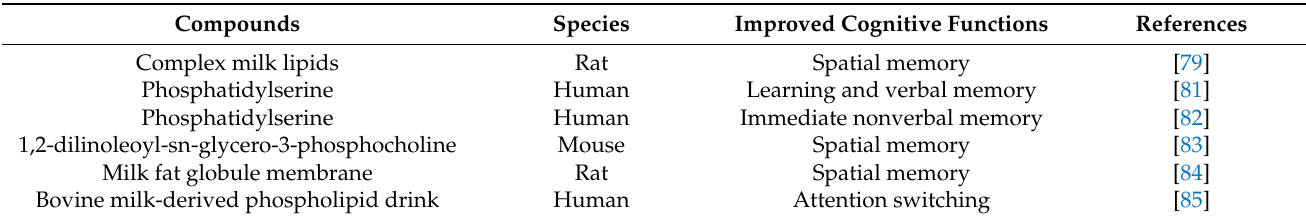
Table 2. Supplementation with dairy phospholipids improves disrupted cognition in stress and aging. Compounds Species Improved Cognitive